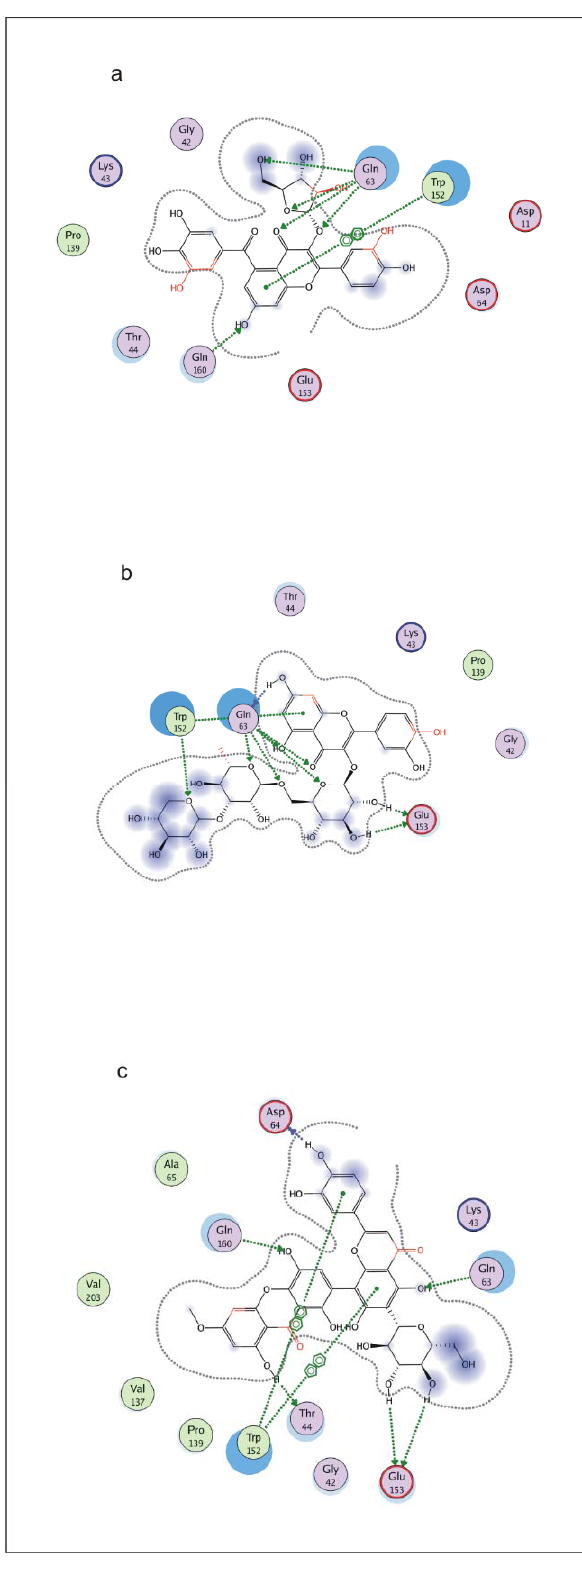
Figure 8. Two ‐ dimensional interaction view of flavonoid atoms with specific residues in active site of V protein. Here, dots are showing specific interactions with ( a ) 5 ‐ galloylquercetin ‐ 3 ‐ O ‐α‐ L ‐ arabinofuranoside, ( b ) quercetin O ‐ glucoside, and ( c ) swertifranche ‐ side.